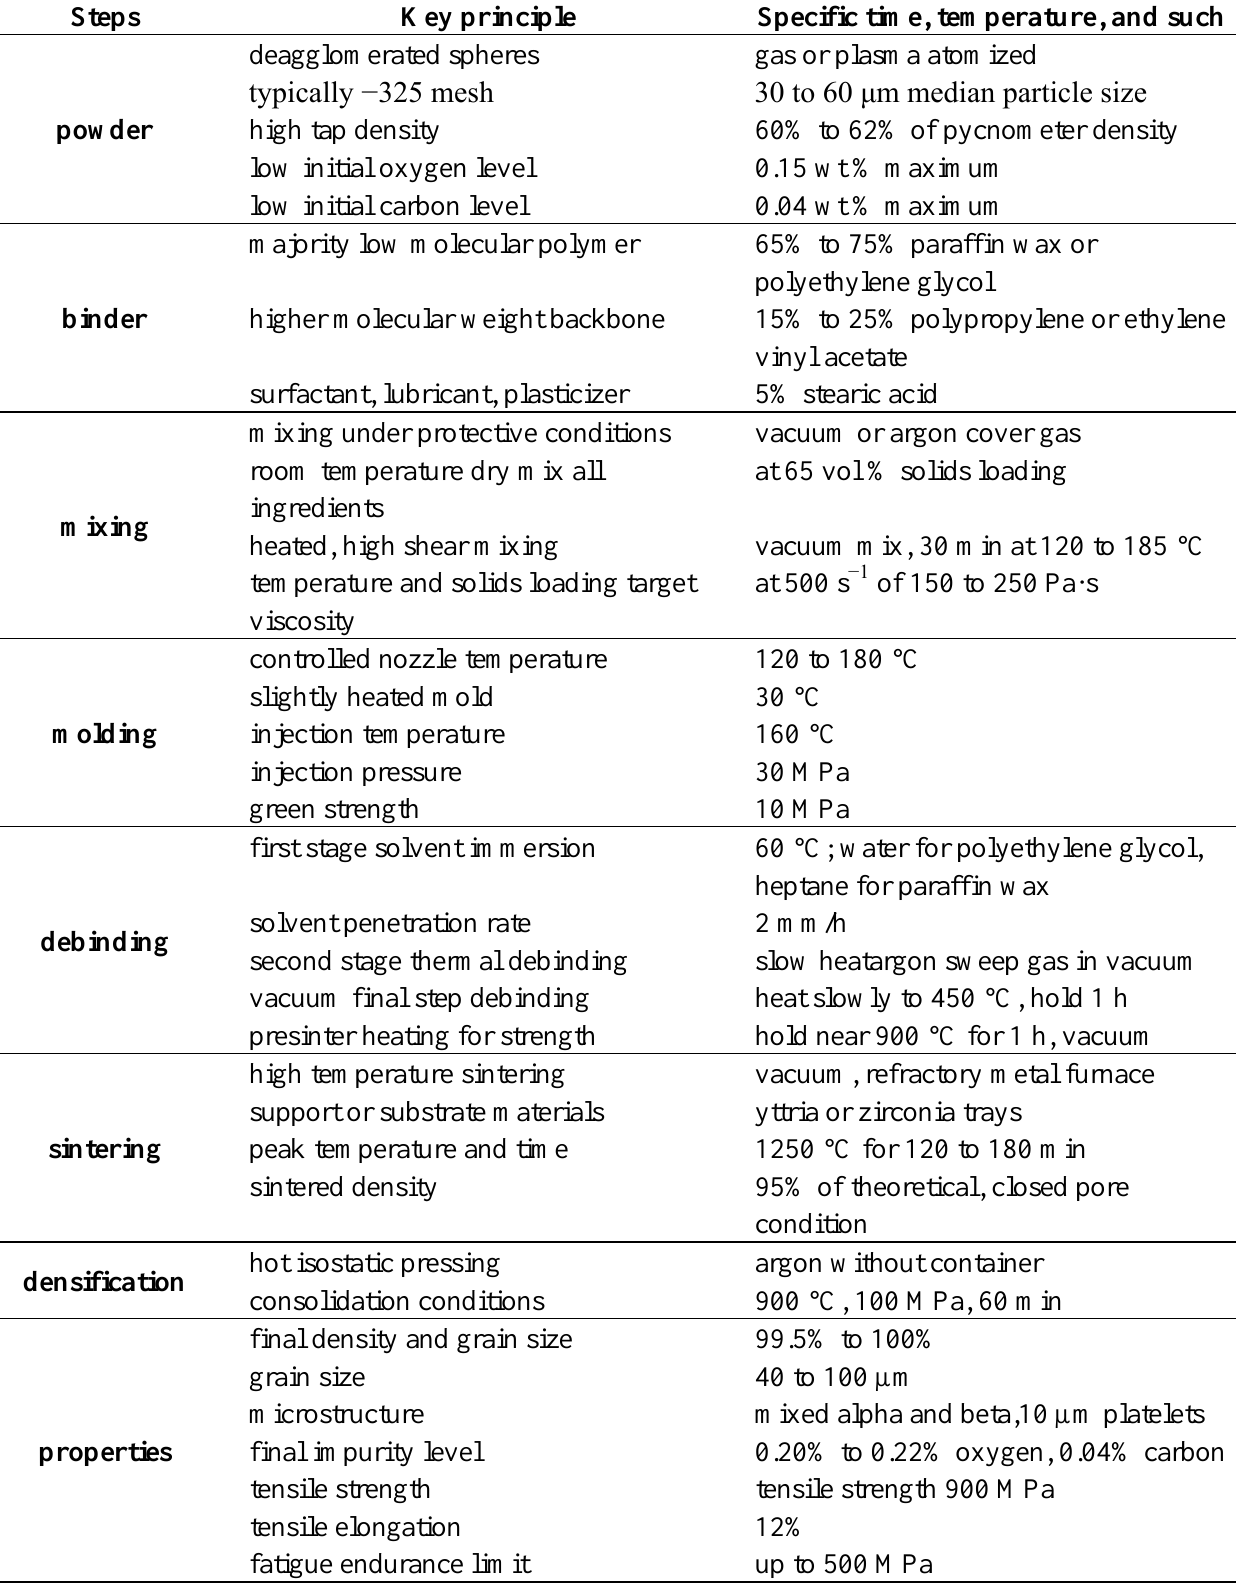
Table 1. A baseline Ti-MIM